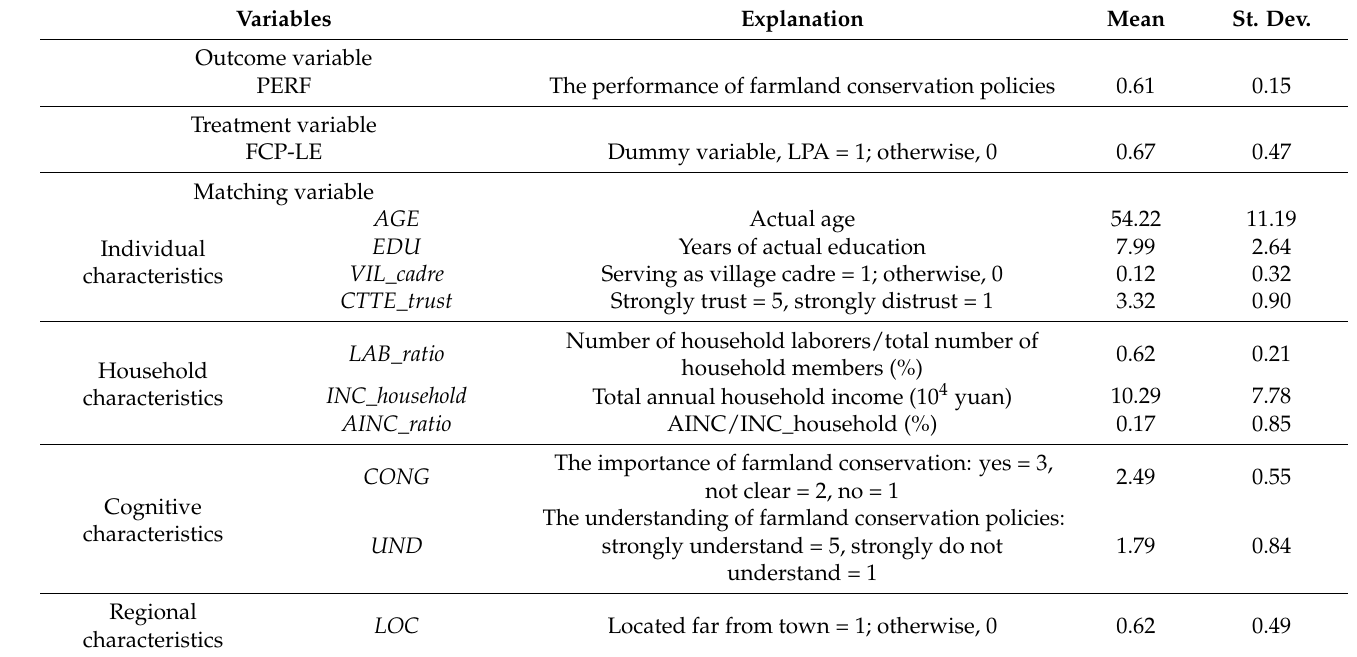
Table 4. Variable definition.